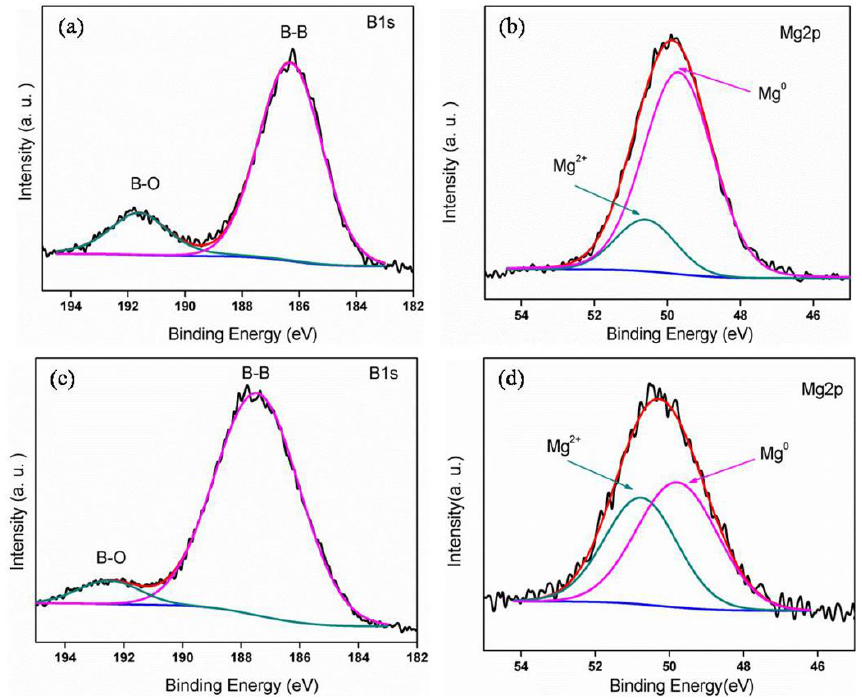
Figure 5. Particle size distribution of Mg/B composite powders.